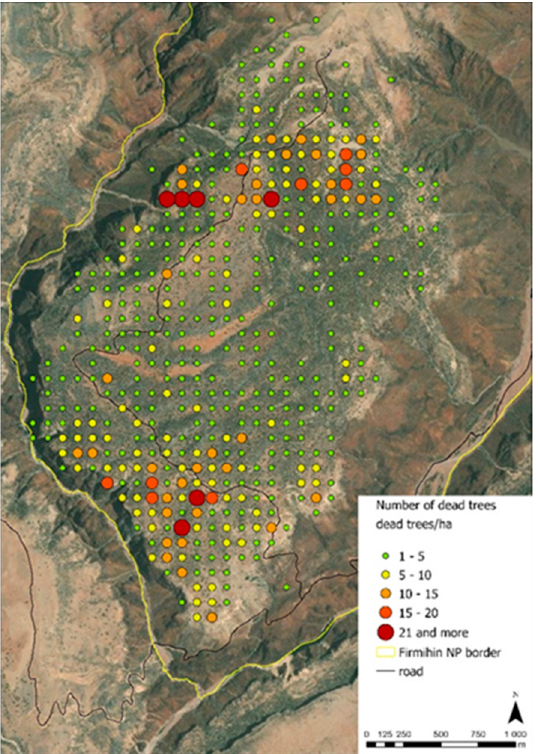
Figure 9. Spatial distribution of the number of uprooted Dracaena trees (number of dead trees/ha) in Firmihin, Socotra Island.